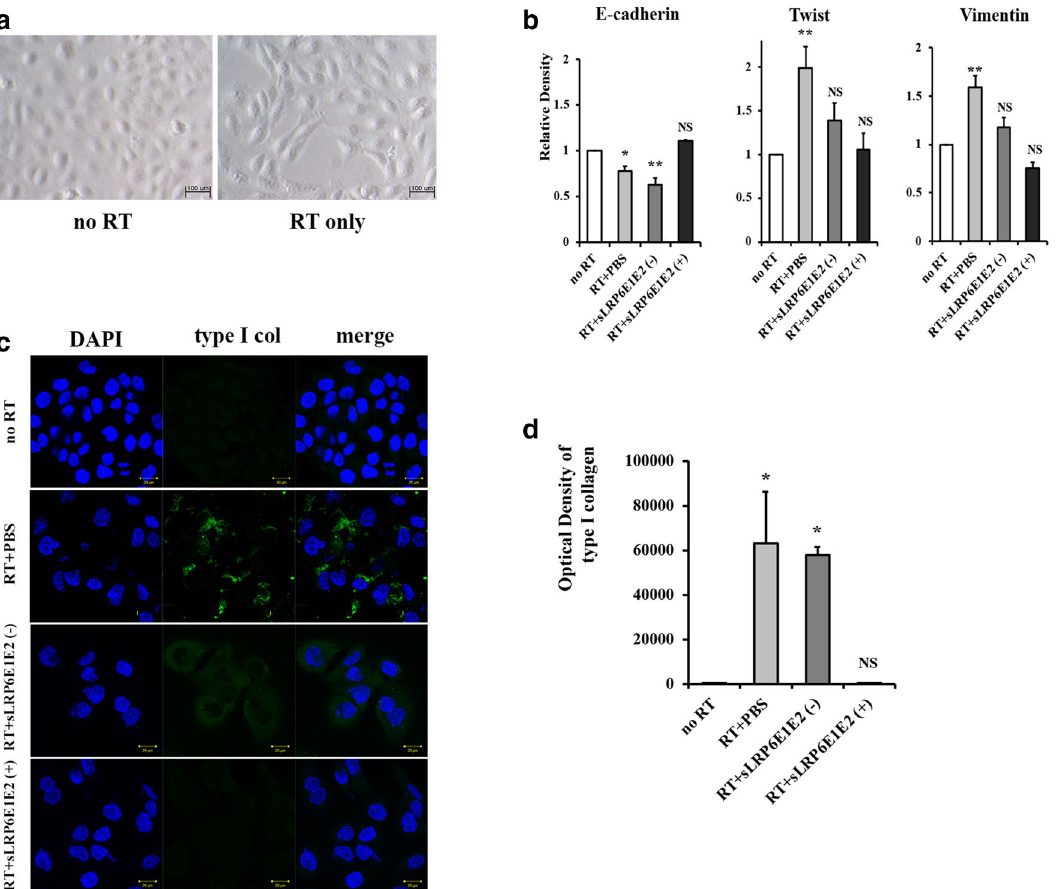
Figure 3. Inhibition of epithelial-to-mesenchymal transition by decoy Wnt receptor sLRP6E1E2 in irradiated HaCaT keratinocytes, and decreased production of collagen type I. ( a ) Under phase-contrast microscopy, spindle-shaped HaCaT keratinocytes were observed after irradiation. ( b ) The mRNA expression of the gene encoding E-cadherin (epithelial marker) increased, while levels of those encoding twist and vimentin decreased (mesenchymal markers). * p < 0.05; ** p < 0.01 vs no radiation. ( c ) After transduction with dE1-k35/sLRP6E1E2 or dE1-k35, Cells were stained with DAPI (blue) and anti-type I collagen (green). ( d ) The expression levels